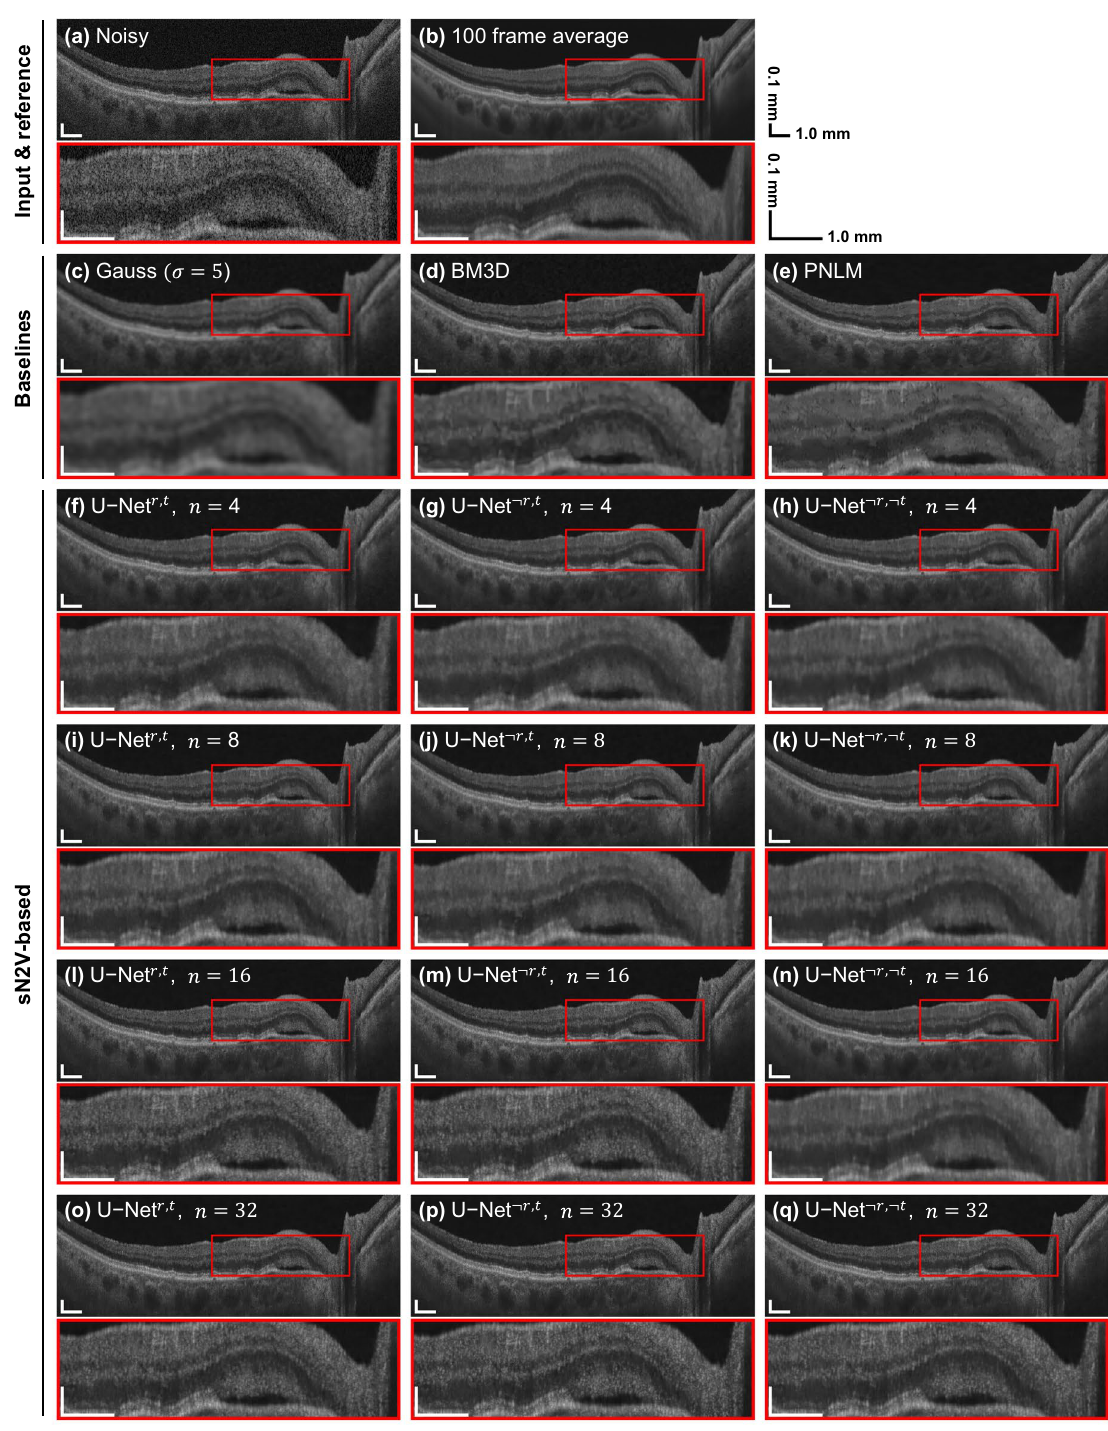
Figure 3. Example for 2D denoising of a B-scan from the evaluation dataset based on different denoising methods or network architectures. All networks were trained with an adapted sN2V 27 strategy. More examples can be found in the Supplementary